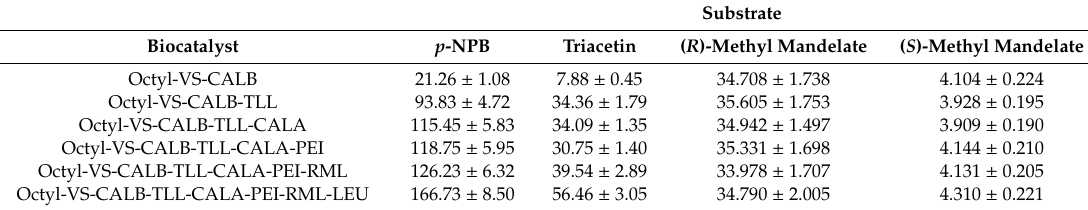
Table 4. Activities of the di ff erent lipase immobilized or co-immobilized biocatalysts during the construction of Octyl-VS-CALB-TLL-CALA-PEI-RML-LEU versus di ff erent substrates. Activities are given as U / g. Activities were determined as stated in